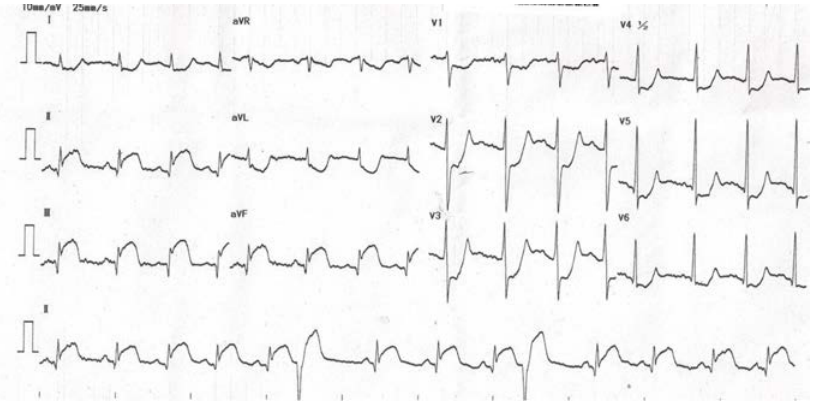
Figure 2. Electrocardiogram (ECG) of the patient showing normal sinus rhythm with occasional premature ventricular contractions (PVC). ST elevation in leads II, III, aVF with ST depression in leads I, aVL, and V1-V6 were noted. These findings were compat- ible with an acute ST-elevation myocardial infarction (STEMI) of the inferior